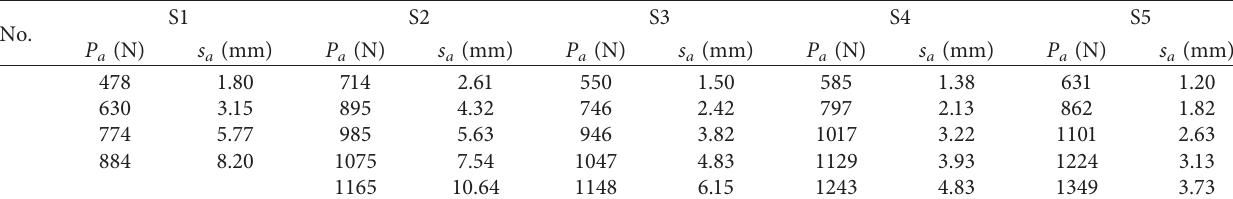
Table 3: Correction function value of branch resistance.